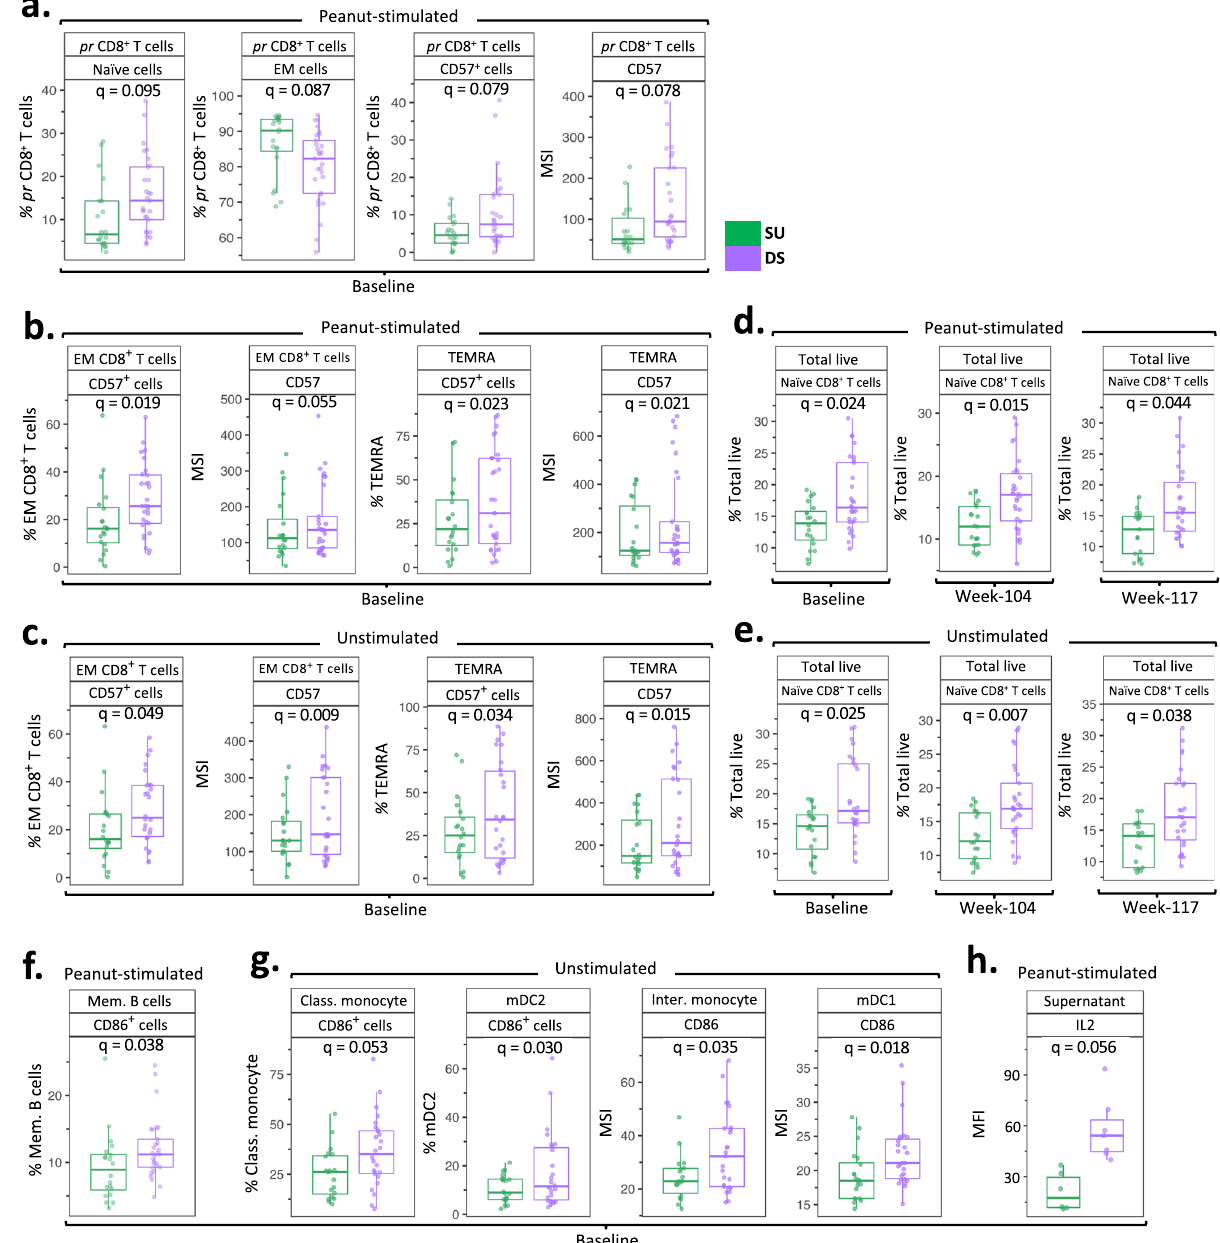
f , g Signi fi cant differences in the frequency or expression of CD86 in memory